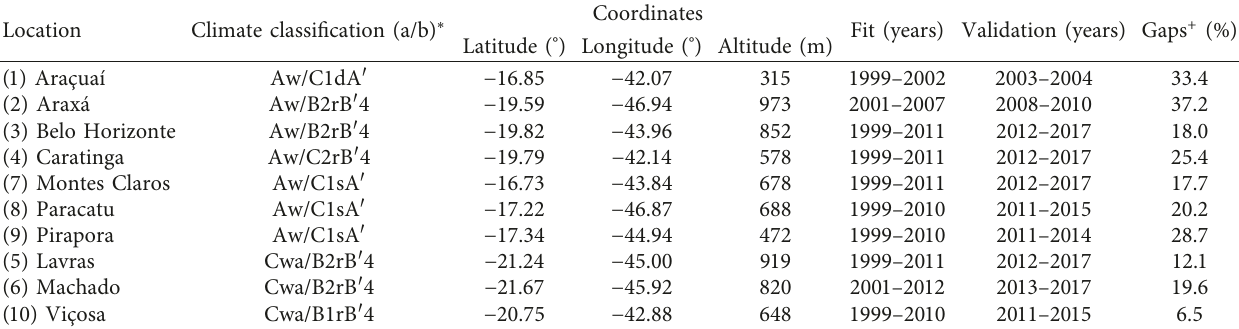
∗ According to the study [42], a � K¨oppen–Geiger’s climate classification (A � tropical; C � subtropical; w � water deficiency in winter; a � hot summer) and b � Thornthwaite’s climate classification (C1 � dry subhumid; C2 � subhumid; B1, B2, B3, and B4 � humid; r � small or no water deficiency; d � small or no water excess; s � moderate water excess in summer; w � moderate water deficiency in winter; A ′ � megathermal; B ′ 2 � mesothermal). + G � ( DA/DT ) · 100, where G is the gap percentage, DA is the amount of missing data in the period, and DT is the amount of